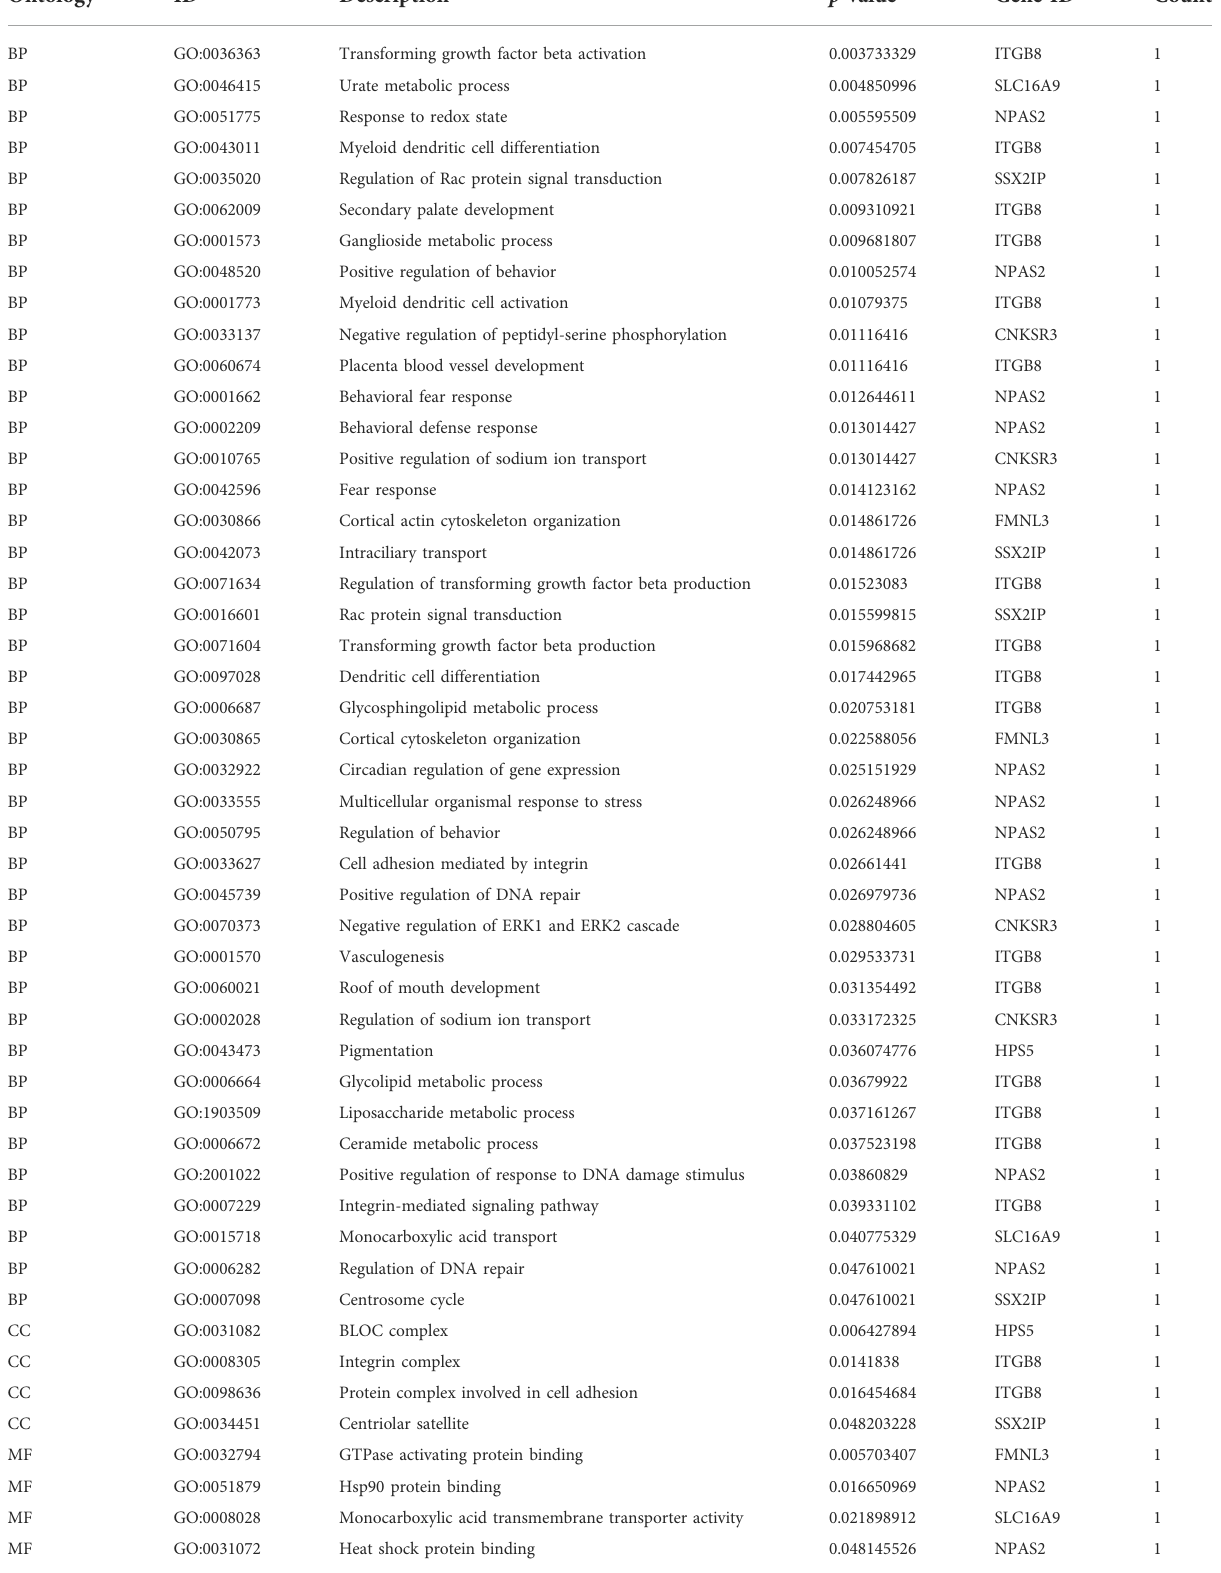
TABLE 2 GO analysis of ceRNA